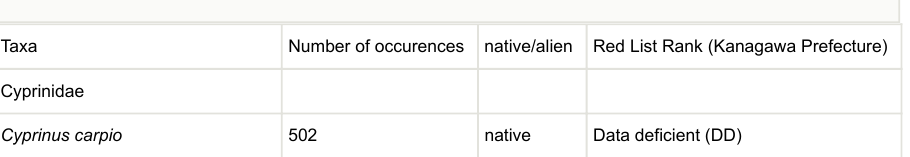
Occurrence of fish taxa in the Tsurumi River Basin represented in the